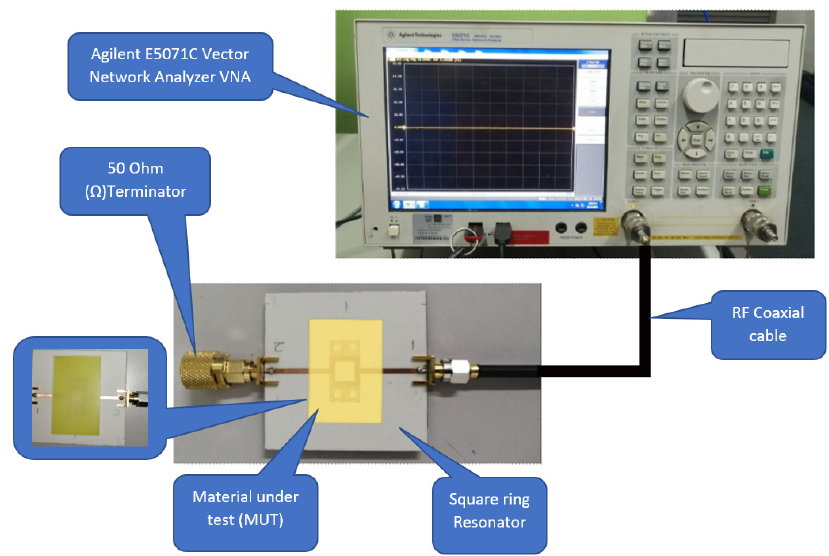
Figure 22. Measurement setup of MUT samples. Table 4. MUT samples and their dimensions.